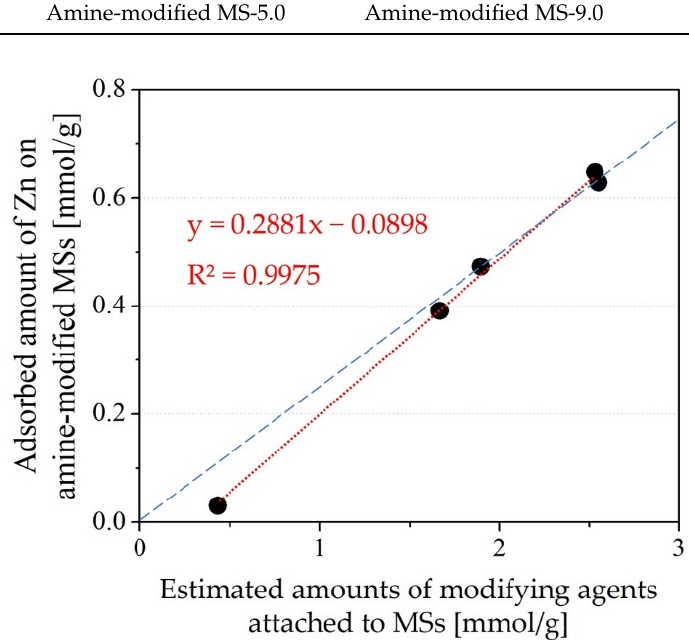
Figure 6. Relation between the amount of modifying agent and amount of Zn adsorbed in a single- component system. The broken line indicates y = 0.25x (one Zn adsorbed against 4 amines). The correlation coefficients against three isotherm models: Langmuir, Freundlich and Temkin and four kinetic models: Pseudo first-order, Pseudo second-order, Elovich, and Intraparticle diffusion, are shown in Table 2. As for isotherm models, Zn adsorption on the amine-modified MSs was found to fit well with the Langmuir isotherm model